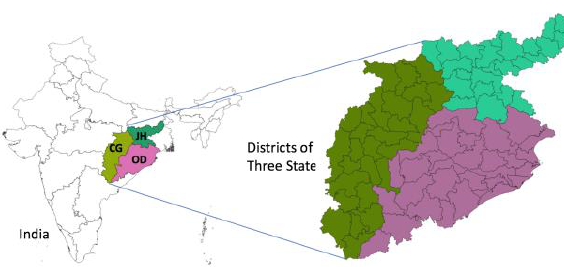
Figure 7 : Study area in the eastern part of India that comprises three states. CG -